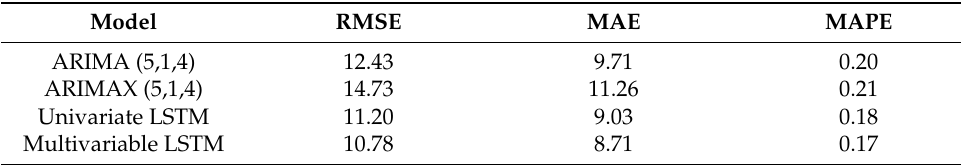
Table 5. The forecasting performance of the four